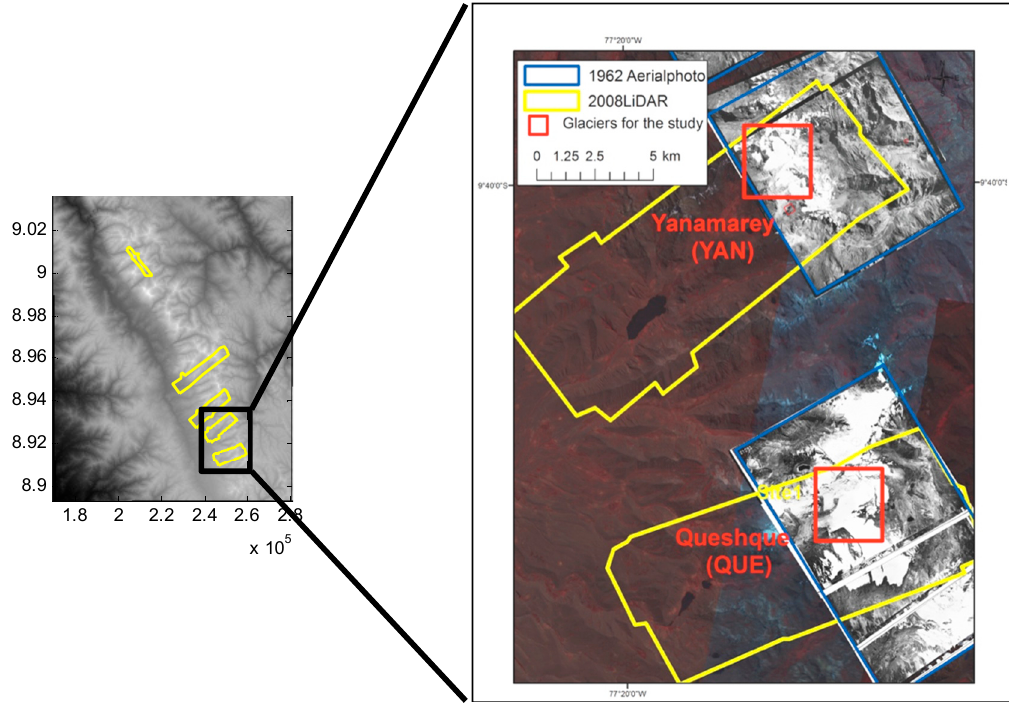
Figure 2. Study glaciers (red outline) and dataset used for this study. Left: Mosaicked Advanced Spaceborne Thermal Emission and Reflection Radiometer (ASTER) Global Digital Elevation Model Version 2 (GDEM V2) with Light Detection and Range (LiDAR) digital elevation models (DEMs) for modeling. Right: The coverage of 1962 aerial photos (blue outline) and 2008 LiDAR flights (yellow outline) over the Southern Cordillera Blanca, Peru. Background is an ASTER mosaic image.